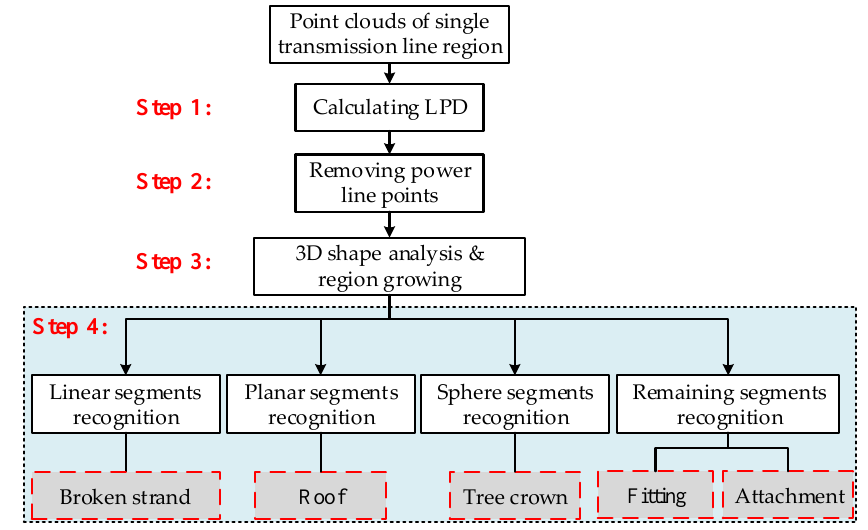
Figure 6. The algorithm flow chart.